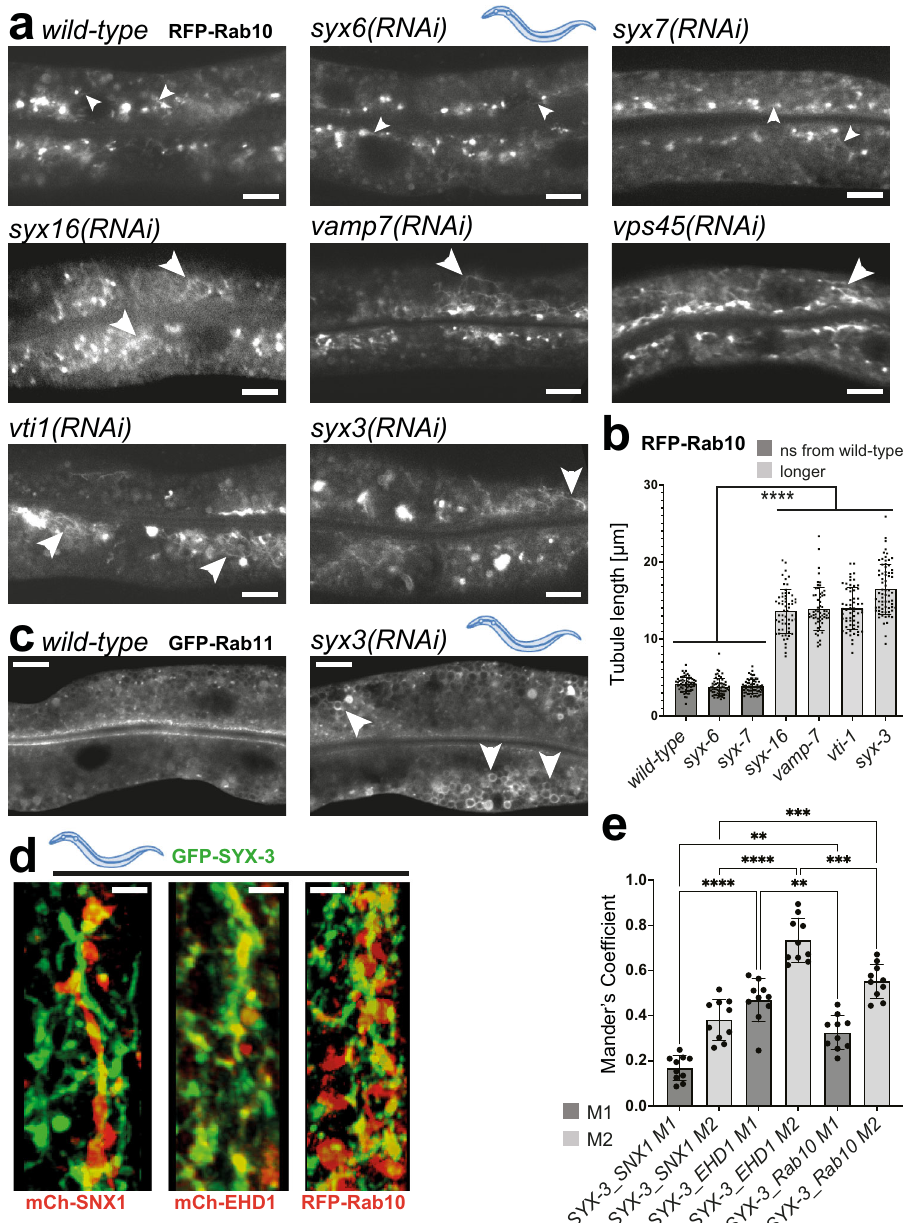
Fig. 4 | Speci fi c SNAREs are used to dock Rab10 vesicles through FERARI. a Knock-downs of syx16, vamp7, vti1 , and syx3 cause FERARI-like phenotypes as seen in vps45(RNAi) (long RFP-Rab10 tubules indicated by large arrowheads), while syx6 and syx7 do not(shorttubulesindicated bysmallarrowheads) ( n =20 animals per condition). b Tubule length was quanti fi ed for n =10 different tubules in n =6 animals examined over three independent RNAi experiments (total n =60). Data are presented asmeanvalues +/ – SD. One-waymultiple comparisonANOVAtest P - values:allindicateddifferencesaresmallerthan P =1E-15.Scalebar:10 µ m. c Knock- down of syx3 causes enlargement of Rab11 compartments, similar to